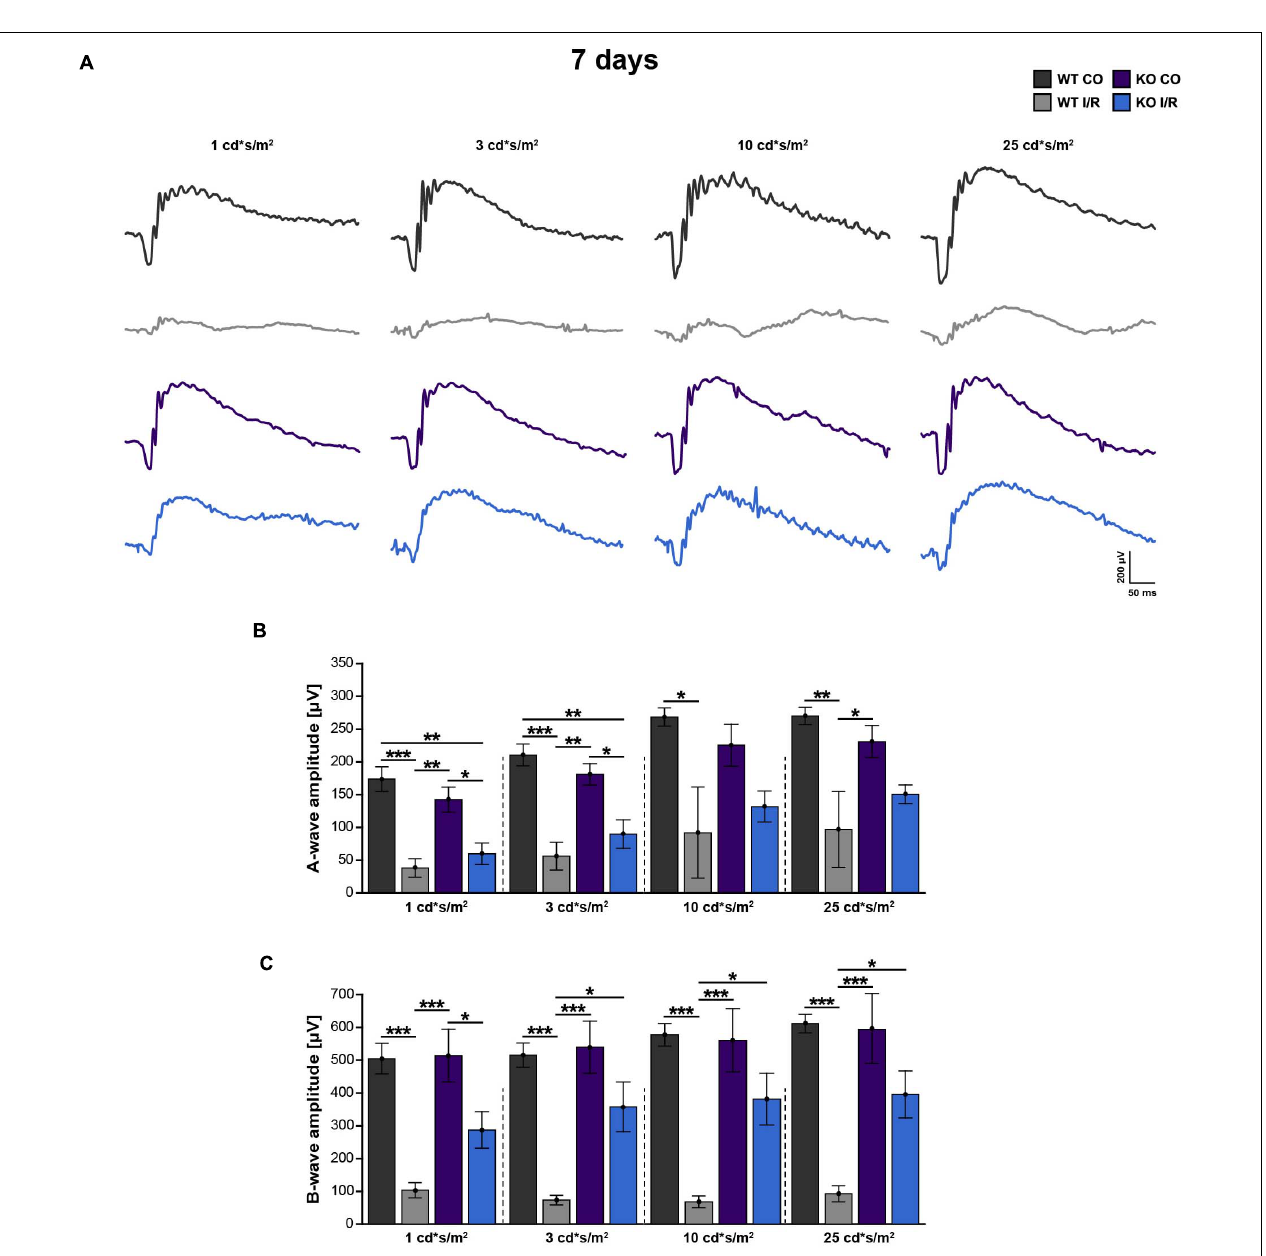
FIGURE 2 | Improvement of retinal function in ischemic Tnc KO mice. (A–C) Retinal function was analyzed in the control WT (WT CO) and Tnc KO (KO CO) groups as well as in the ischemic WT (WT I/R) and Tnc KO groups (KO I/R) at 7 days after I/R. (A) Exemplary ERG waveforms for all groups at the flash luminances of 1, 3, 10, and 25 cd*s/m 2 are shown. (B,C) The flash luminance (cd*s/m 2 ) and the a- or b-wave amplitude size ( µ V) are indicated in the graphs. Significant lower a- and b-wave amplitudes were found in both genotypes after I/R. However, the KO I/R group showed significantly reduced a-wave amplitudes only at lower flash luminances in comparison to the control KO group. Interestingly, in the KO I/R group, b-wave amplitudes from 3 to 25 cd*s/m 2 were significantly higher in comparison to the WT I/R group. * p < 0.05, ** p < 0.01, *** p < 0.001. n = 5/group. Groups were analyzed using two-way ANOVA followed by Tukey’s post hoc test. Data are shown as mean ± SEM. cd: candela; µ V: micro volt; m: minutes; s: